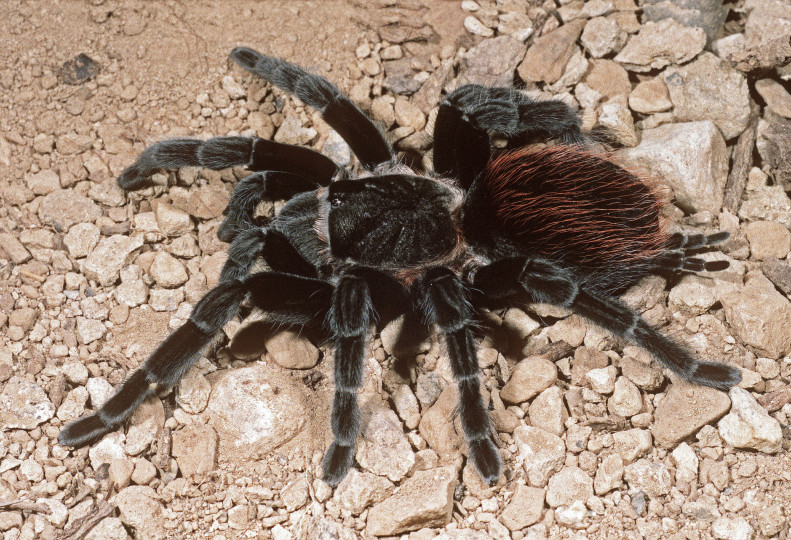
Brachypelma
sabulosum (F. O. P.-Cambridge, 1897) female from Tikal, Guatemala. Photo: Rick C. West.